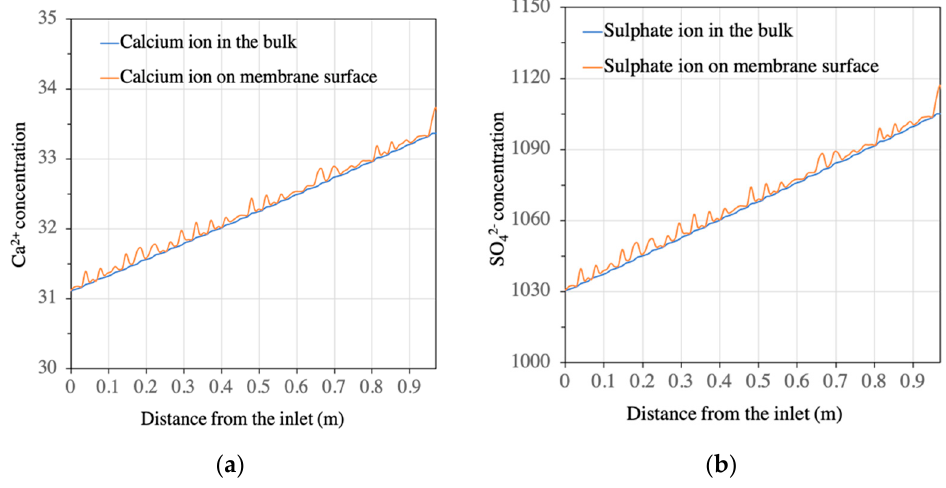
Figure 3. Calcium and sulphate ion concentrations in both bulk solution and on membrane surface in the 1 st element of the 1 st stage: ( a ) calcium ion; ( b ) sulphate ion.